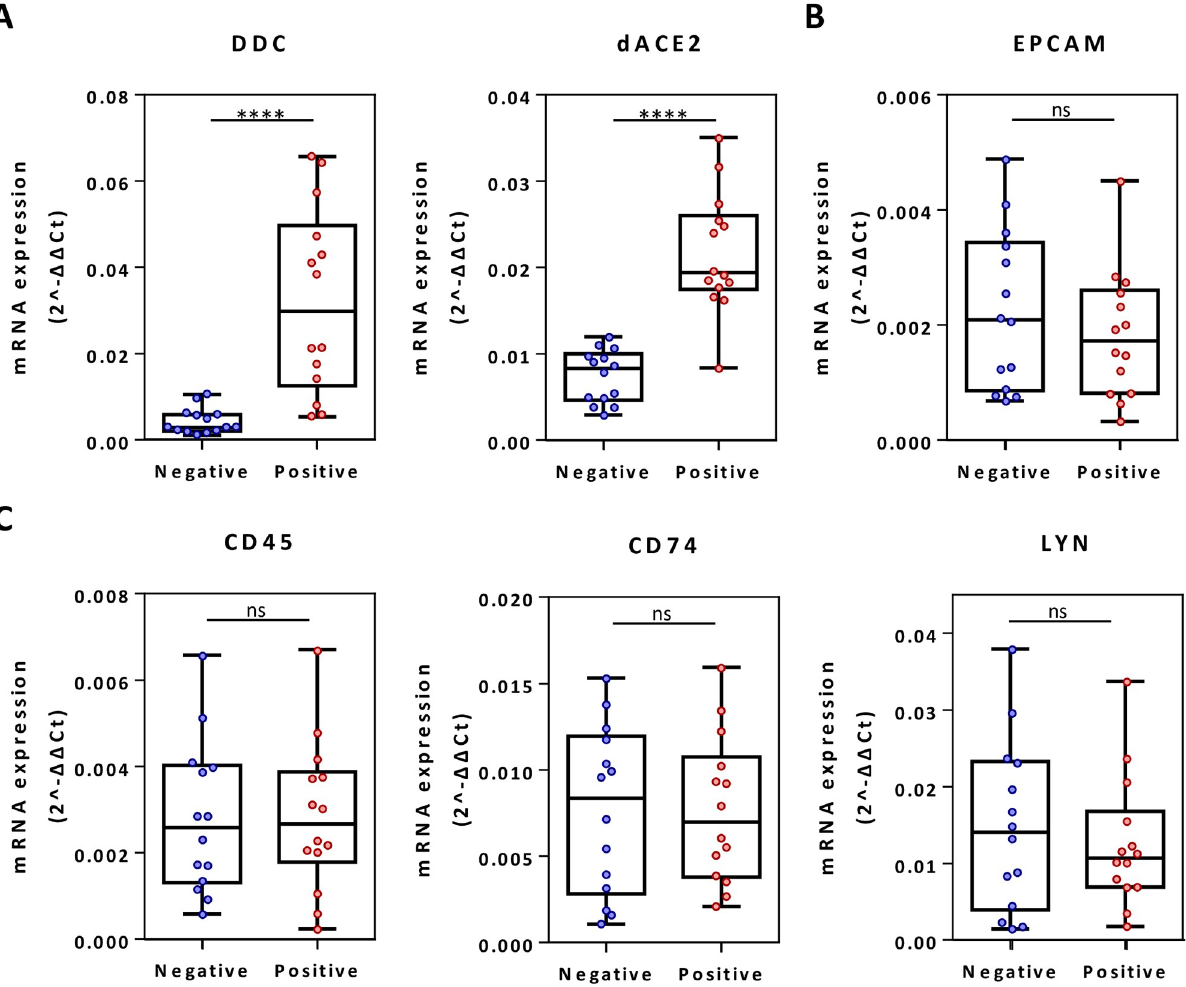
Fig 3. Comparison of the mRNA expression of DDC and dACE2 (A), epithelial marker EPCAM (B) and immune cell markers CD45 , CD74 and LYN (C) between COVID-19 patients and non-infected individuals. Data are represented as box plots; line in the middle, median; box edges, 25 th to 75 th centiles; whiskers, range of values. p values were calculated with student’s t-test. ���� :p < 0.0001, ns: Non-significant.